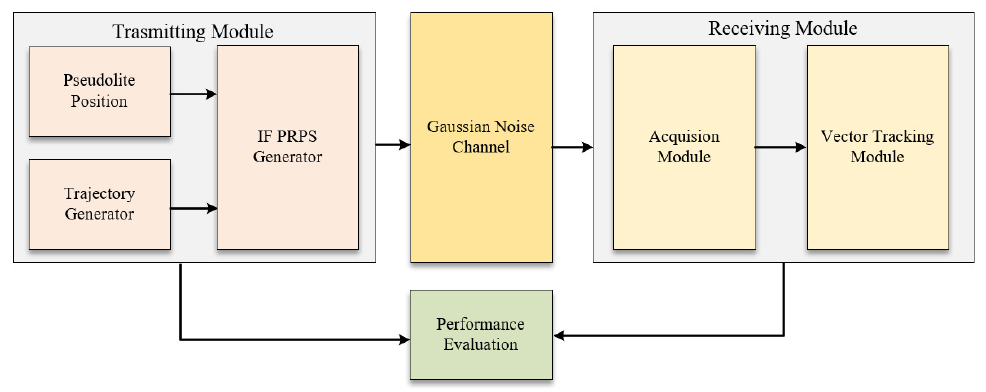
Figure 6. Block diagram of the simulation